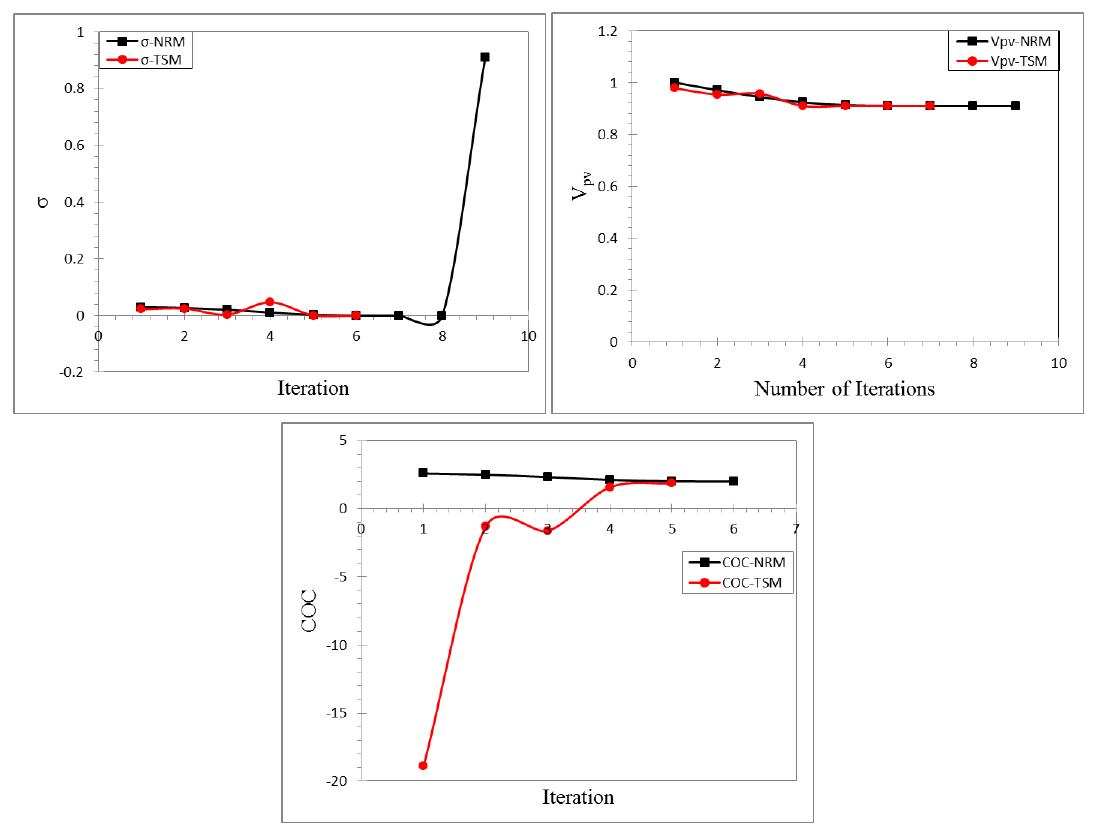
Fig.4: Obtained solutions of the study